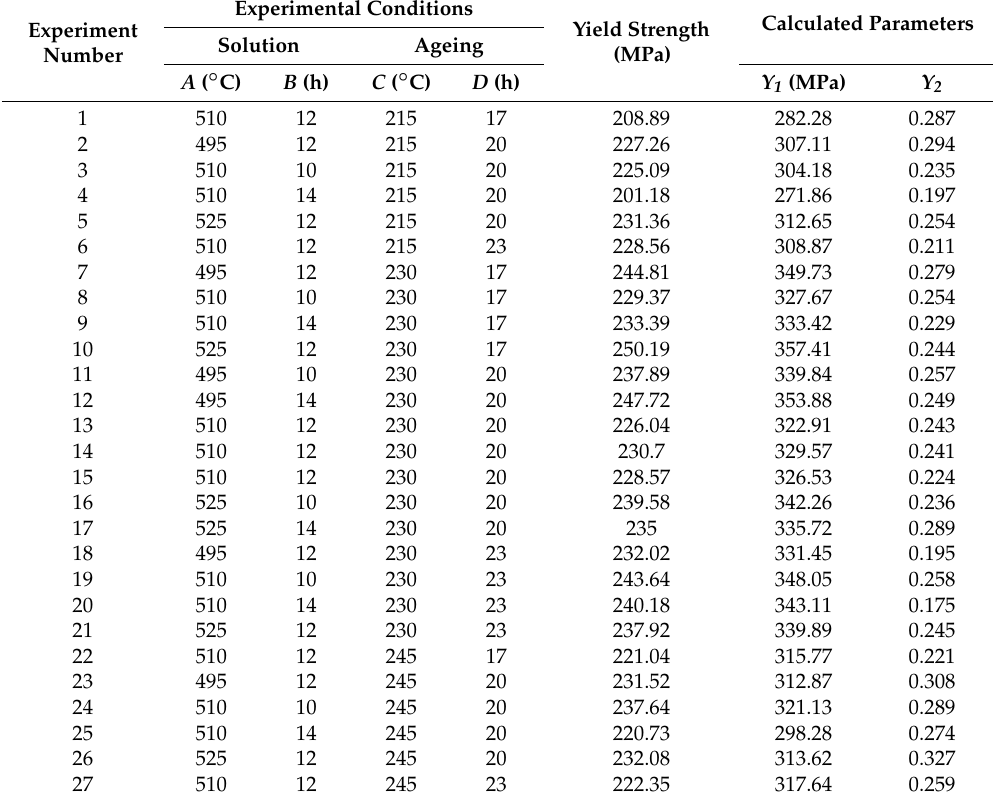
Table 5. Experimental scheme and data calculation